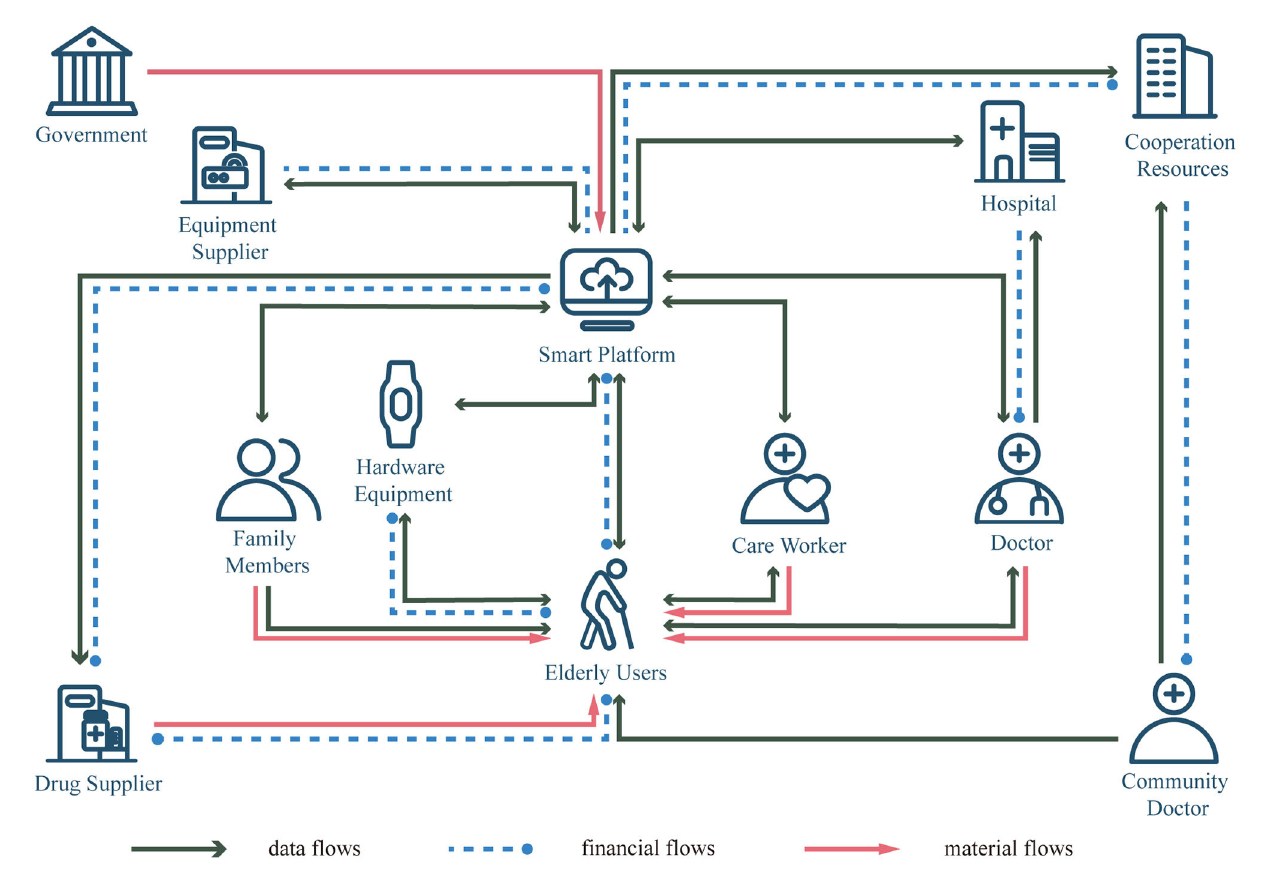
FIGURE4 The whole interaction process of the telemedicine-based older adults remote health management service